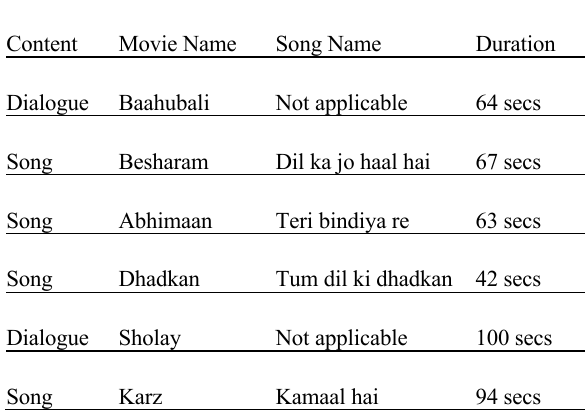
Table 1: Media descriptions of audio-visual